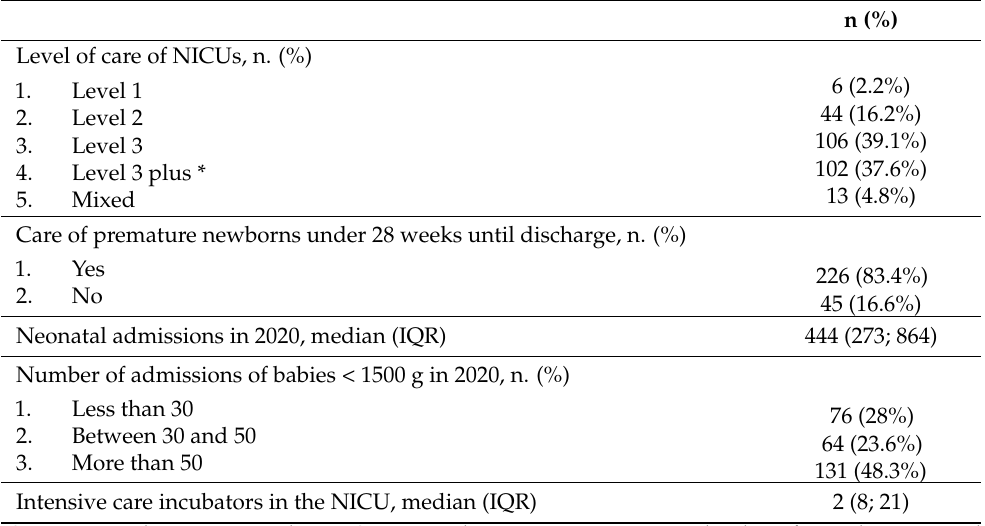
Figure 2. Graphic representation of the number of responses to the survey per country in which more than 6 neonatology units have answered. Table 1. Demographics of responding neonatal units.